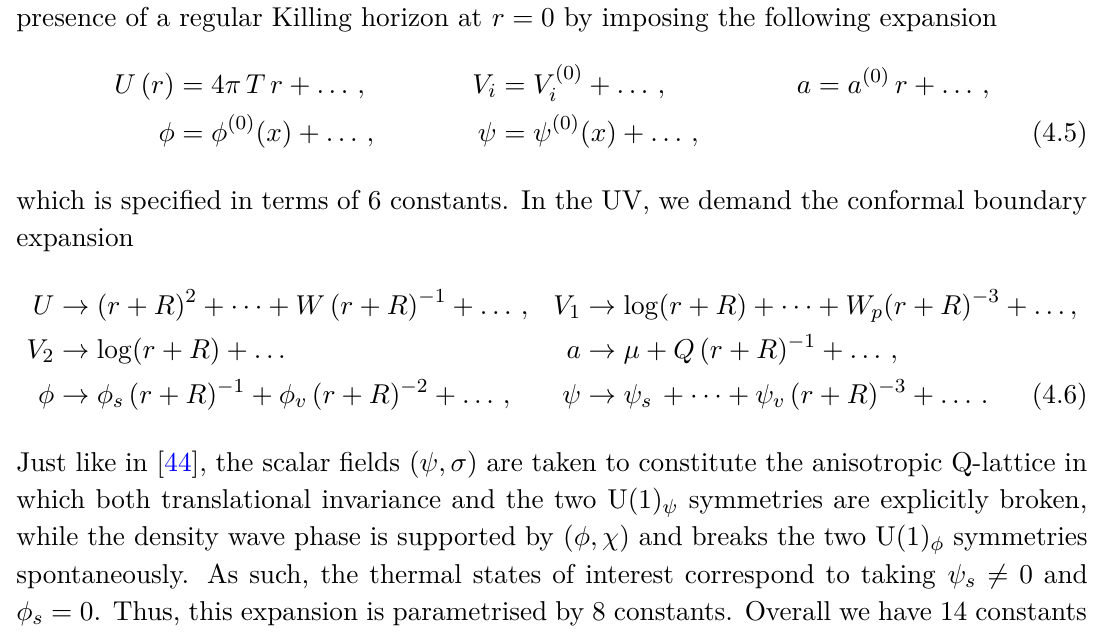
Figure 1 . Plot of the critical temperature at which the background Q-lattice becomes unstable as a function of k for ( k s 1 , k s 2 , ψ s , γ, δ, µ, B ) = mode corresponds to k = 0